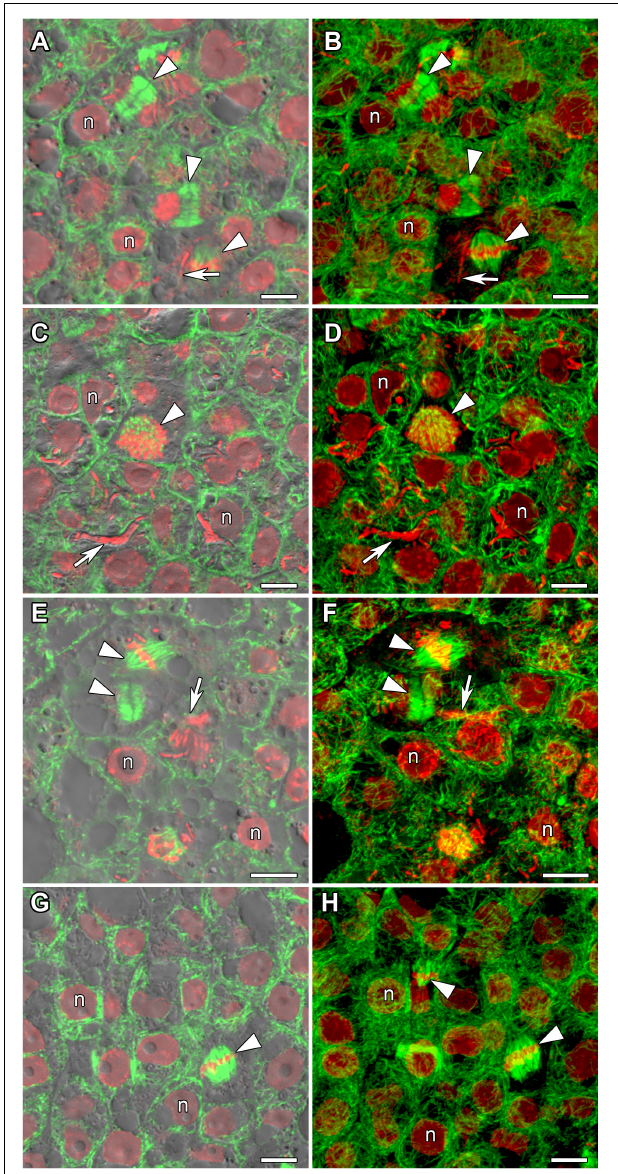
FIGURE 4 | Cortical and endoplasmic microtubule organization in infected cells of infection zone in G. max (A,B) , G. soja (C,D) , P. vulgaris (E,F) , and L. japonicus (G,H) nodules. n, nucleus; triangles indicate infection droplets; arrows indicate infection threads. Confocal laser scanning microscopy of (A–F) 50 µ m and (G,H) 35 µ m longitudinal vibratome sections. Immunolocalization of tubulin (microtubules), green channel; DNA staining with propidium iodide (nuclei and bacteria), red channel and (A–F) immunolocalization of MAC265 (infection droplets), yellow channel. (A,C,E) Merged images of a single optical section of differential interference contrast and green, red, and yellow channels. (G) Merged images of a single optical section of differential interference contrast and green, and red channels. (B,D,F) Maximum intensity projections of (B,D) 40 and (F) 30 optical sections in green, red, and yellow channels. (H) Maximum intensity projections of 40 optical sections in green and red channels. Scale bar = 10 µ m.